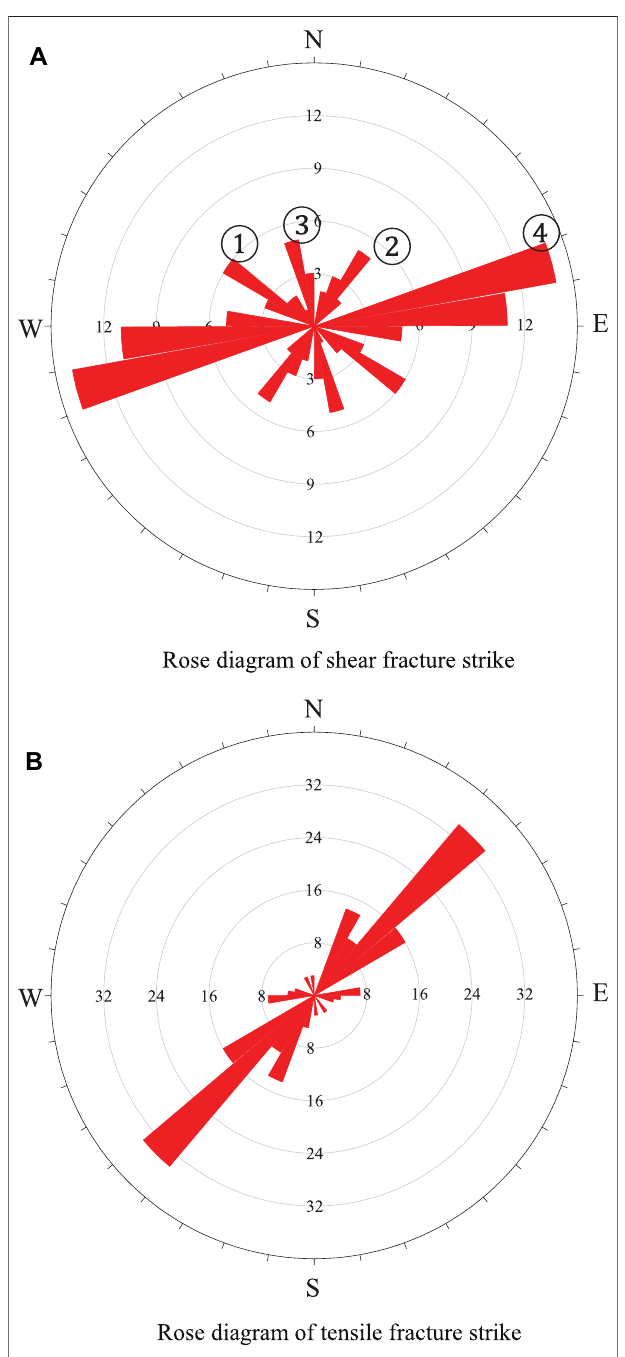
FIGURE 4 | Rose diagram of fracture trend in shale gas well in the Dingshan area. (A) Rose diagram of shear fracture strike. (B) Rose diagram of tensile fracture strike. TABLE 1 | The uniaxial compression test results for the Longmaxi formation shale